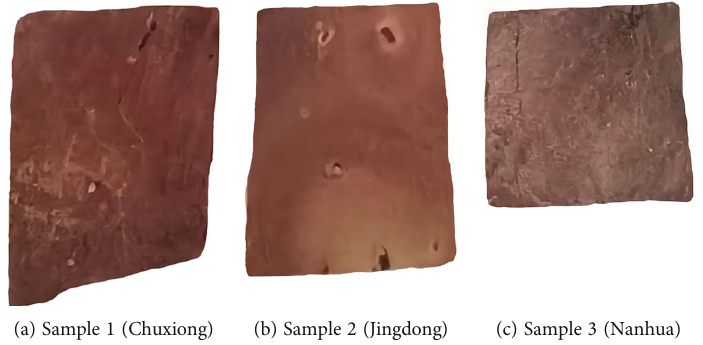
Figure 6: Nanoindentation sample.